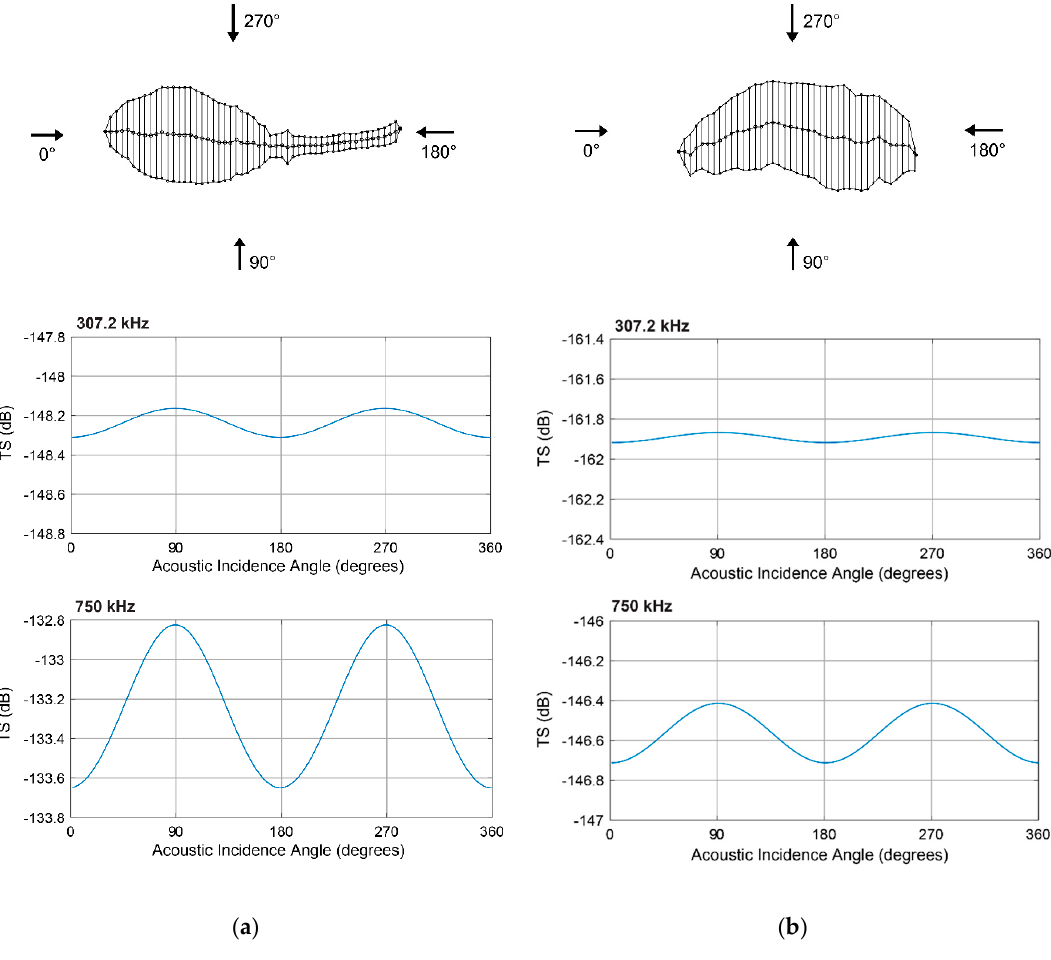
Figure 13. Theoretical target strength (dB) vs. acoustic incidence angle of 0.518 mm Oithona sp. and 0.201 mm Paracalanus sp. based on distorted wave-Born approximation (DWBA) model. These zooplankton were modeled in two frequencies (307.2 and 750 kHz) according to the frequency used in ADCP. The width of the cylinder for Oithona sp. and Paracalanus sp. were 0.01 mm and 0.005 mm, respectively. The peak of TS occurred at dorsal (270°) and ventral (90°) aspect.